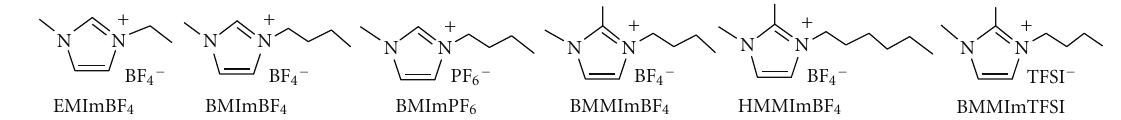
Figure 1: Chemical structures of the imidazolium-based ILs used in this work.